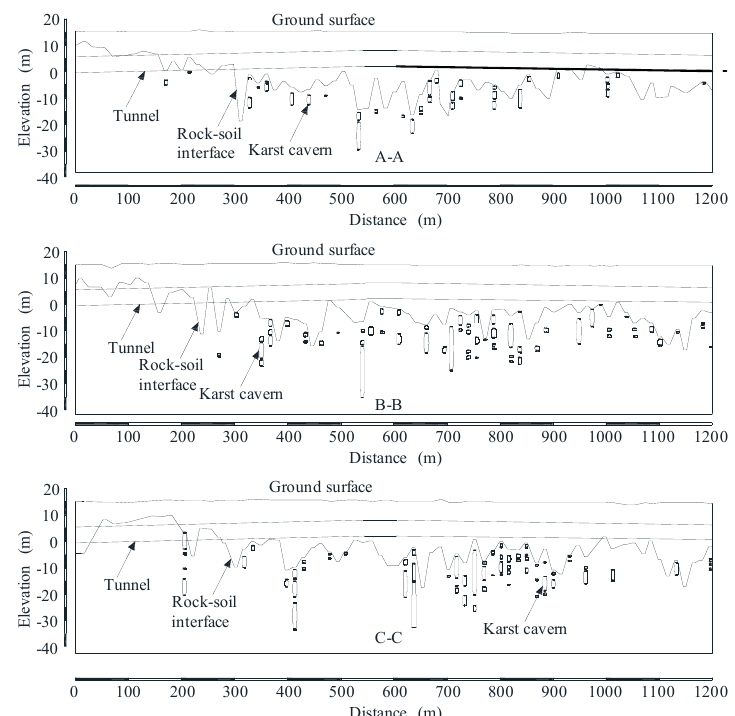
Figure 12. Longitudinal distribution profiles of the karst caverns discovered in the Ma-Lian section (For location of profiles A-A, B-B, and C-C please refer to Figure 13).